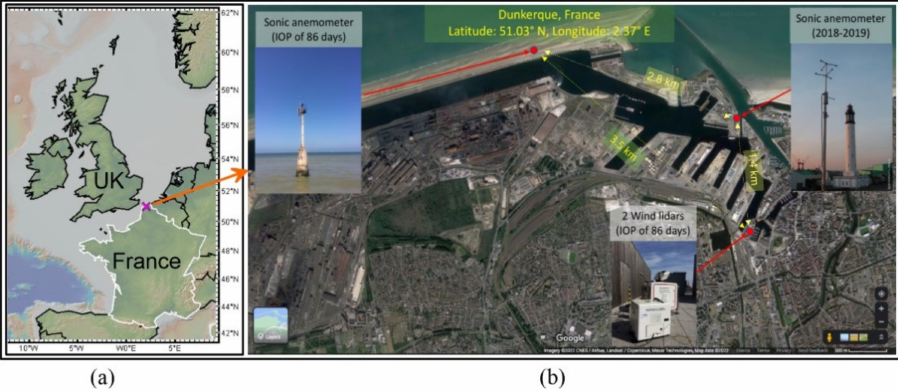
Figure 1. Measurement location map of North West of Europe ( a ); location in Dunkerque of the different experimental devices used in the measurement campaign (2 ultrasonic anemometers and 2 wind lidars) ( b